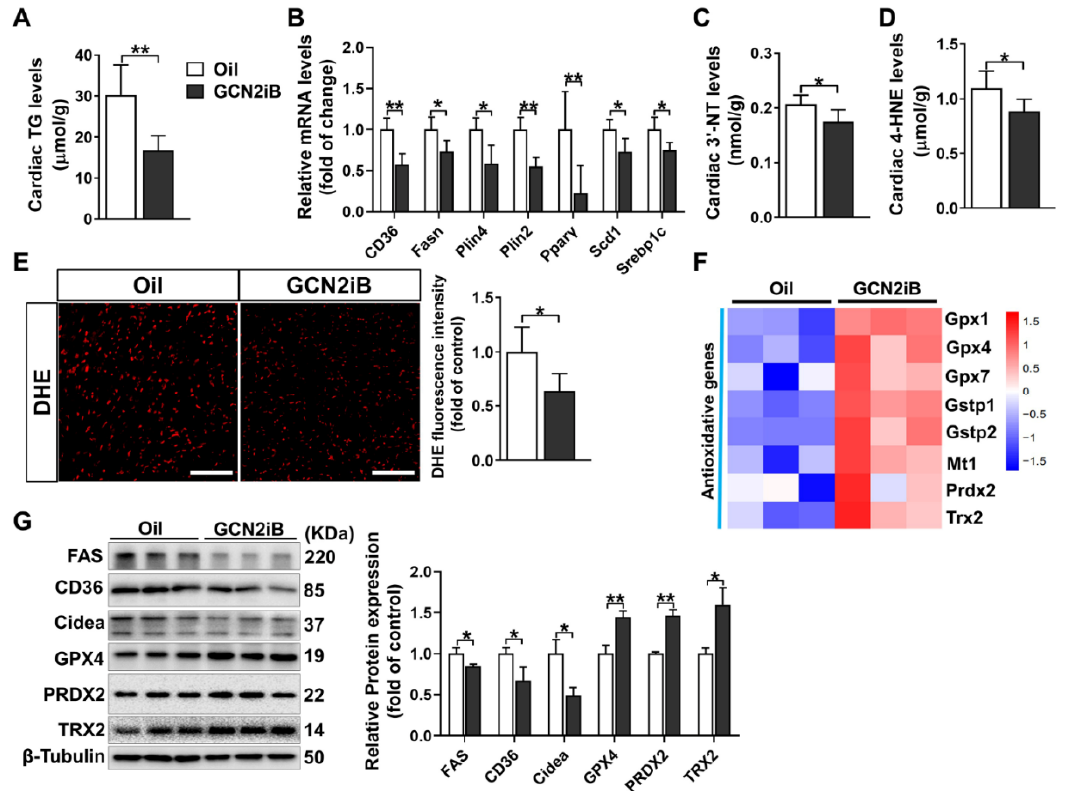
Figure 4. GCN2iB ameliorates myocardial lipid accumulation and oxidative stress in T2D mice. ( A ) Cardiac triglyceride (TG) levels were measured in oil- and GCN2iB-treated T2D mice. ( B ) The mRNA levels of lipid metabolism-related genes were measured. ( C , D ) Cardiac 3 ′ -nitrotyrosine (3 ′ -NT) and 4-hydroxynonenal (4-HNE) levels were measured. ( E ) Representative heart sections were stained with dihydroethidium (DHE), and the relative fluorescence intensity was quantified. Scale bar = 50 μ m. ( F ) The expression profiles of some antioxidative genes are displayed as a heatmap. ( G ) Heart lysates were examined by Western blot. In Figure a–e, N = 5; in Figure 4(f,g), N = 3; values are expressed as the means ± SD; * indicates p < 0.05; ** indicates p < 0.01.